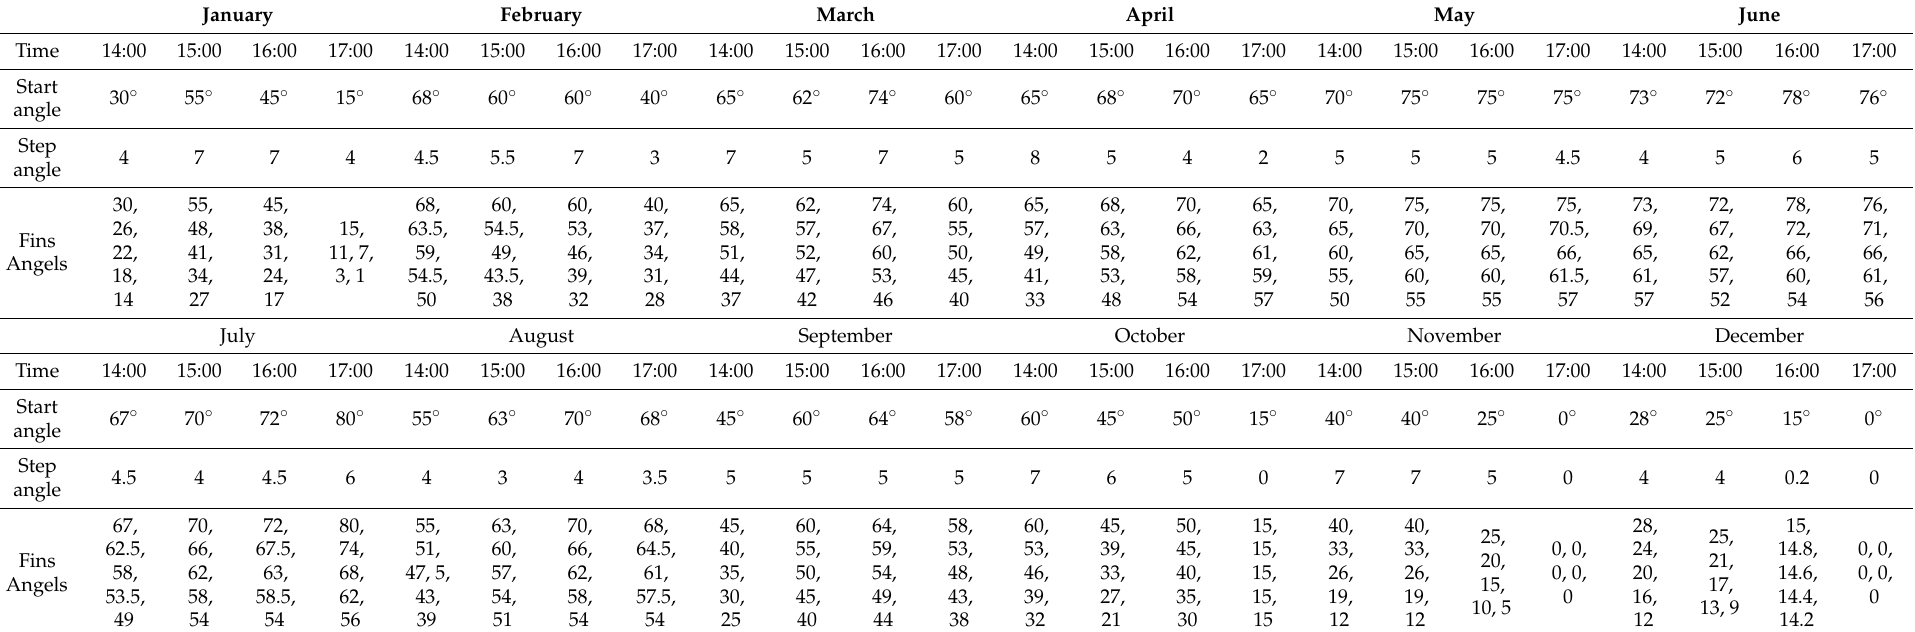
Table 3. Optimized values for the IKS Source: The